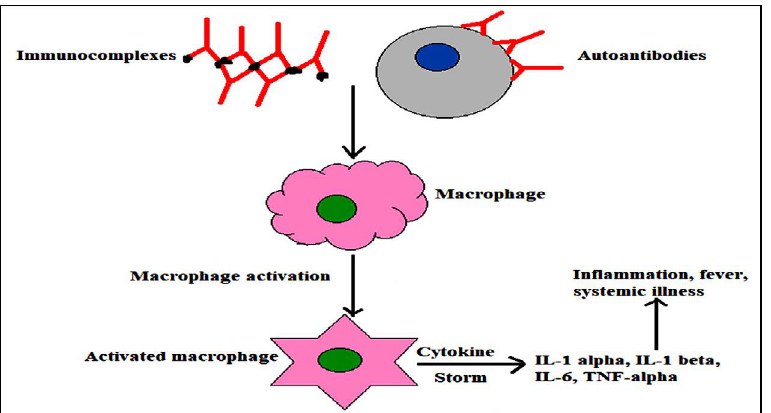
Fig. 2. Auto-antibodies or immune complexes can also stimulate macrophages resulting in production of enormous amount of